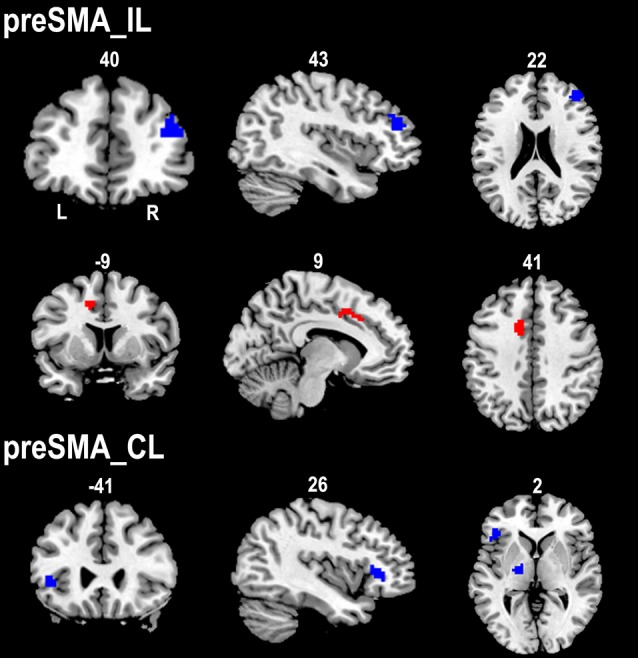
Contrast maps of the rsFCs of the preSMA between stroke patients and healthy subjects. Red blobs and blue blobs indicate increased and decreased functional connectivity in patients compared with healthy subjects, respectively. CL, contralesional hemisphere; IL, ipsilesional hemisphere; rsFC, resting-state functional connectivity; SMA, supplementary motor area.